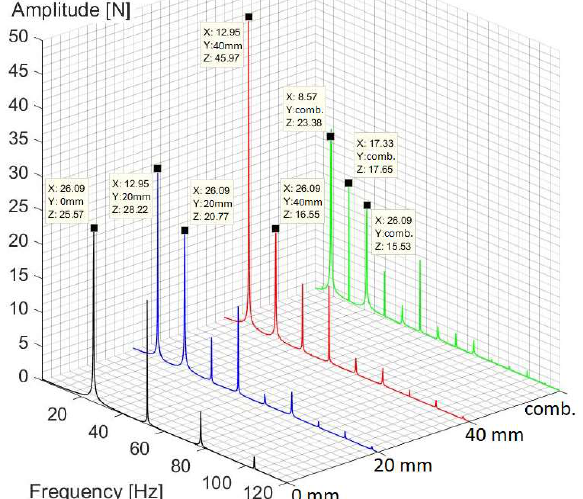
Table 5 The overview of maximum static pressure amplitudes behind the rib